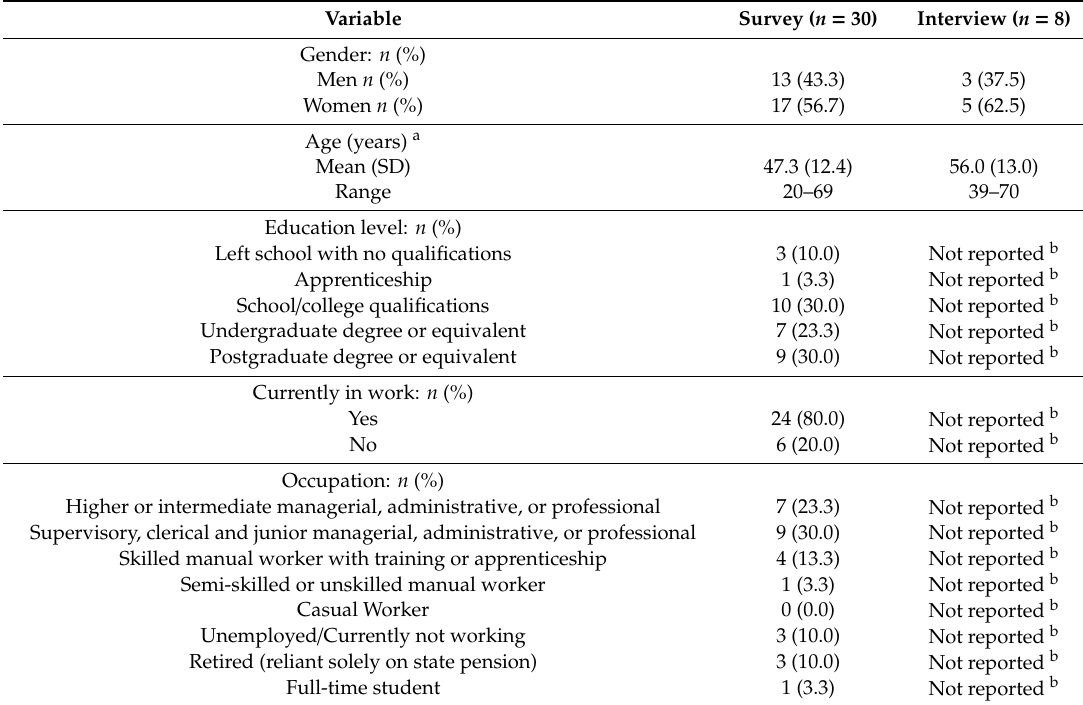
Table 2. Demographic characteristics of survey and interview